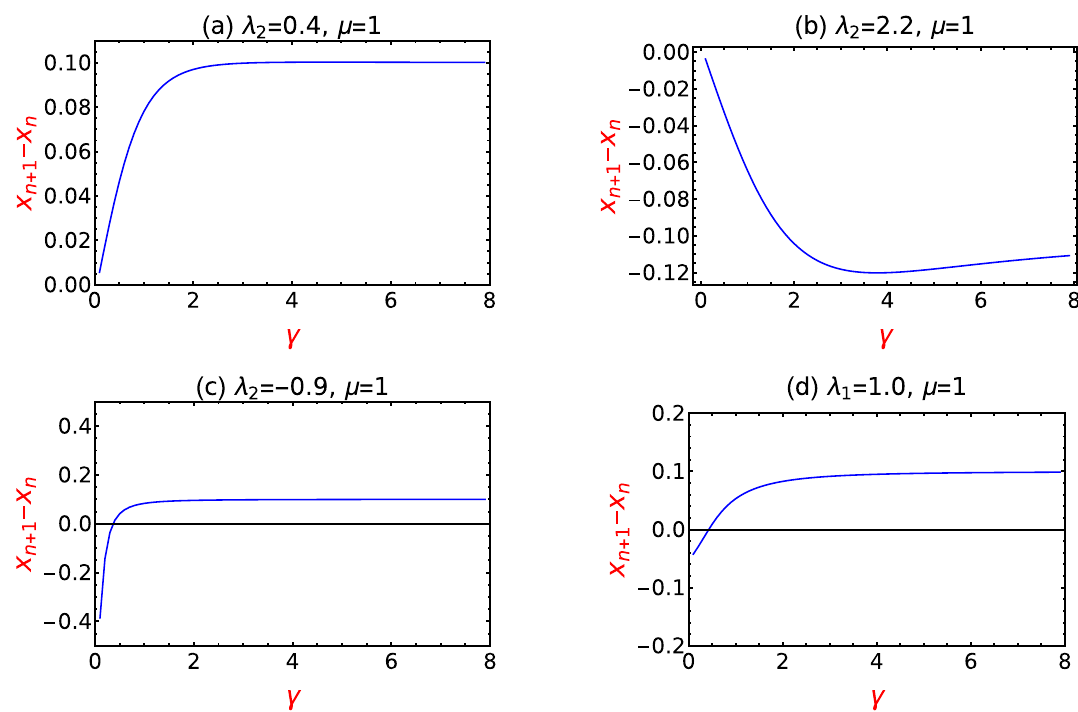
Figure 10. Variations in the difference of critical lines ( x n + 1 − x n ) with γ for fixed values of (cid:31) 1 and (cid:31) 2